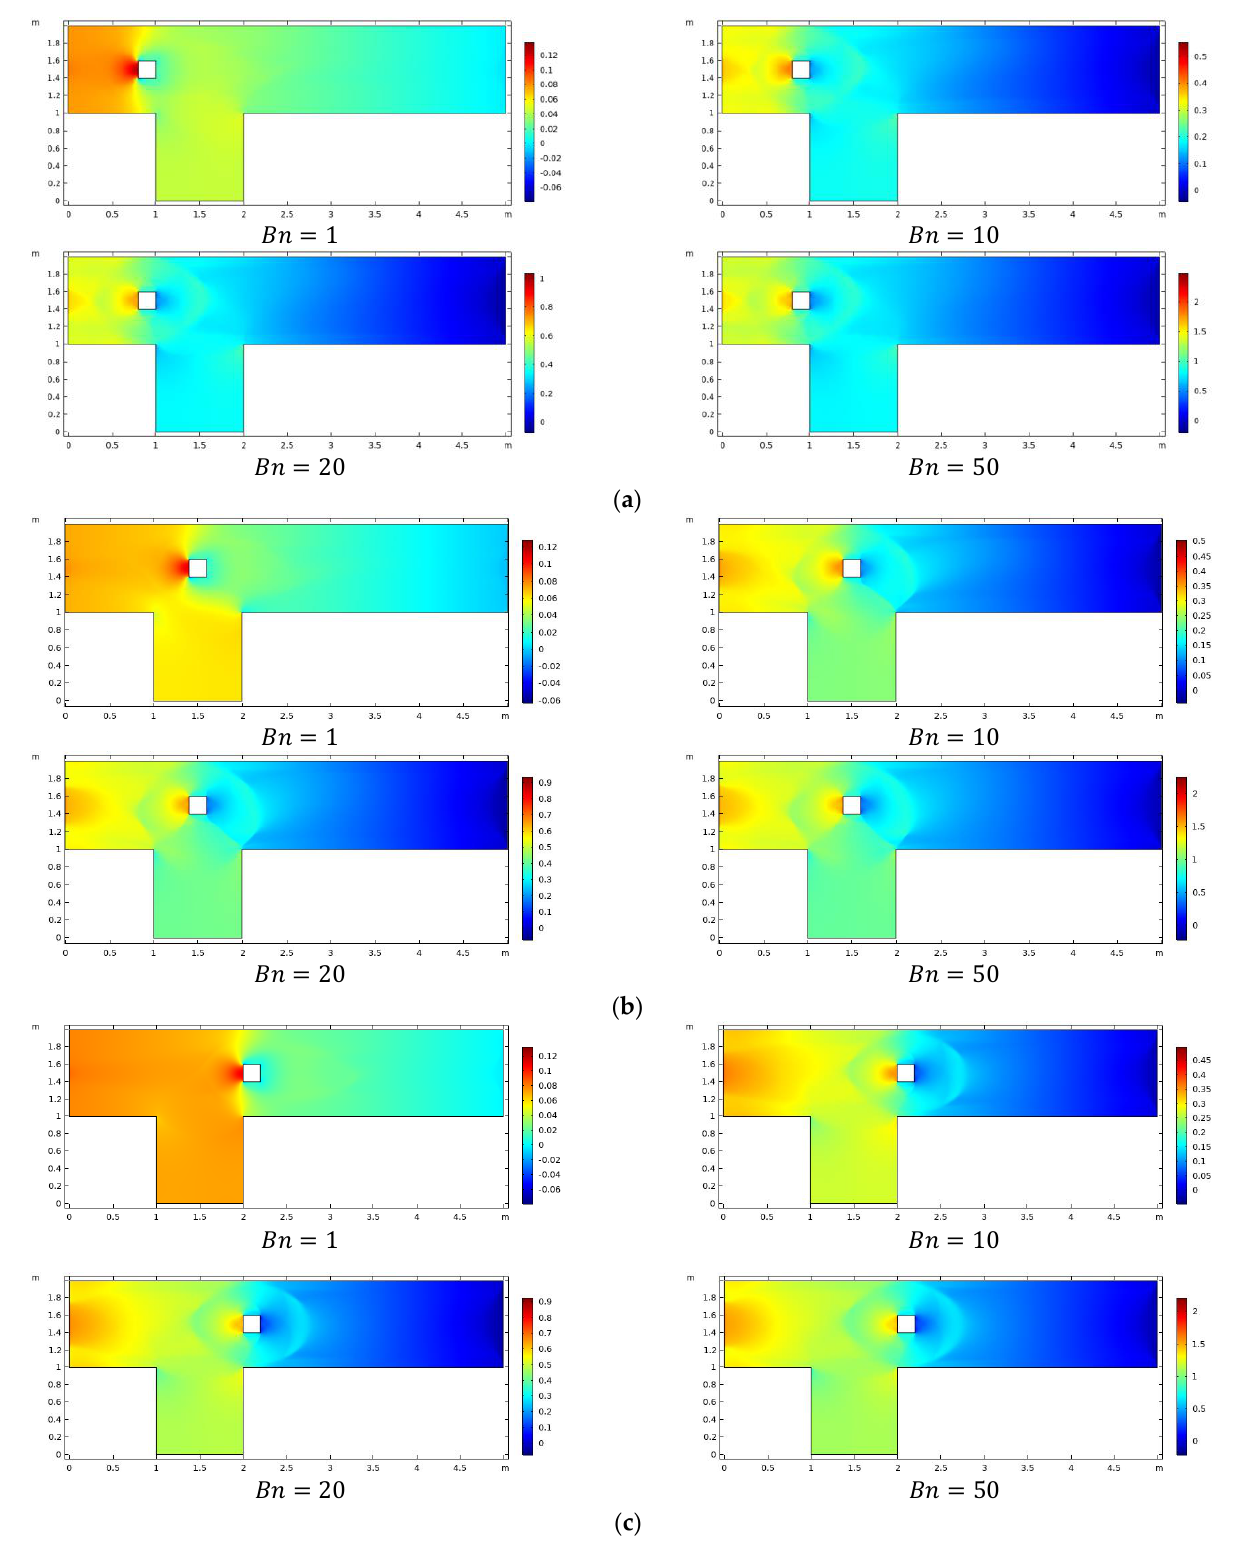
Figure 4. ( a ): Pressure when the center of obstacle at 𝐶 1 for various 𝐵𝑛 . ( b ): Pressure when the center of obstacle at 𝐶 2 for various 𝐵𝑛 . ( c ): Pressure when the center of obstacle at 𝐶 3 for various 𝐵𝑛 .